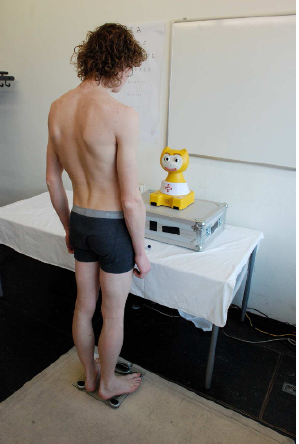
Figure 1. Setup of the experiment